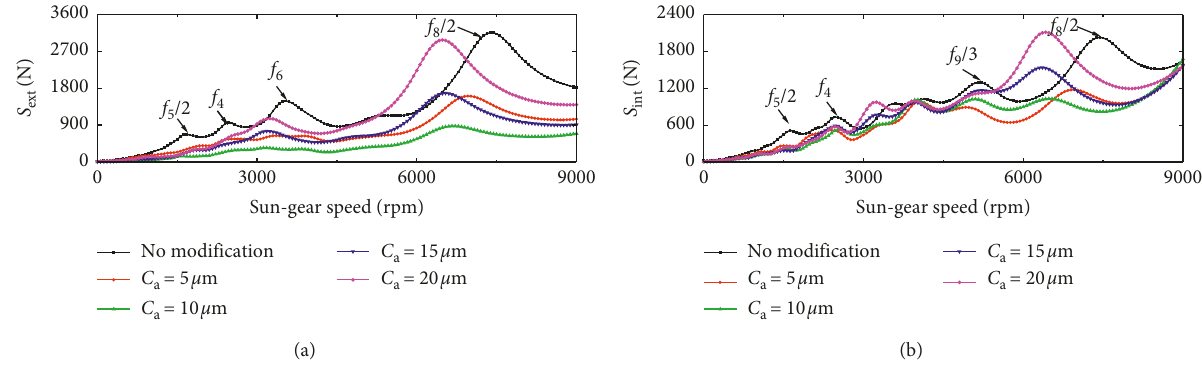
Figure 8: Dynamic tooth loads on external and internal meshes versus sun-gear speed influence of the amount of TPM: (a) sun-planet meshes and (b) ring-planet